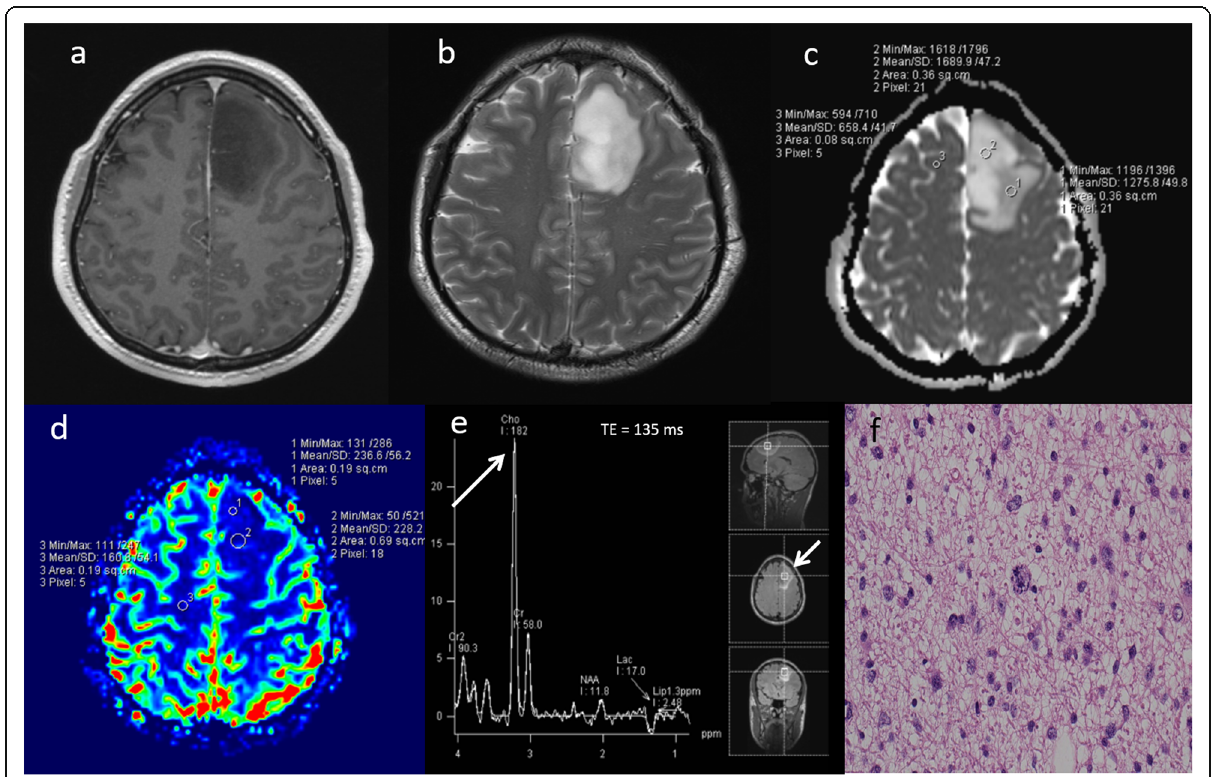
Fig. 5 Targeting biopsy for a non-enhancing tumour. Conventional MRI: a , b Post-contrast T1W and T2W sequences demonstrate a large non- enhancing space occupying mass lesion without significant oedema. Multiparametric MRI: c , d Heterogeneous ADC and rCBV values throughout the lesion. e Multi-voxel MRS clearly shows focal area of very high Cho/Cr (3.1) and very small lactate peak. f Targeted biopsy taken from the area of highest choline peak (arrow). Histopathology shows anaplastic astrocytoma with moderately atypical astrocytic cells in a fibrillary background with a few abnormal mitoses (WHO grade